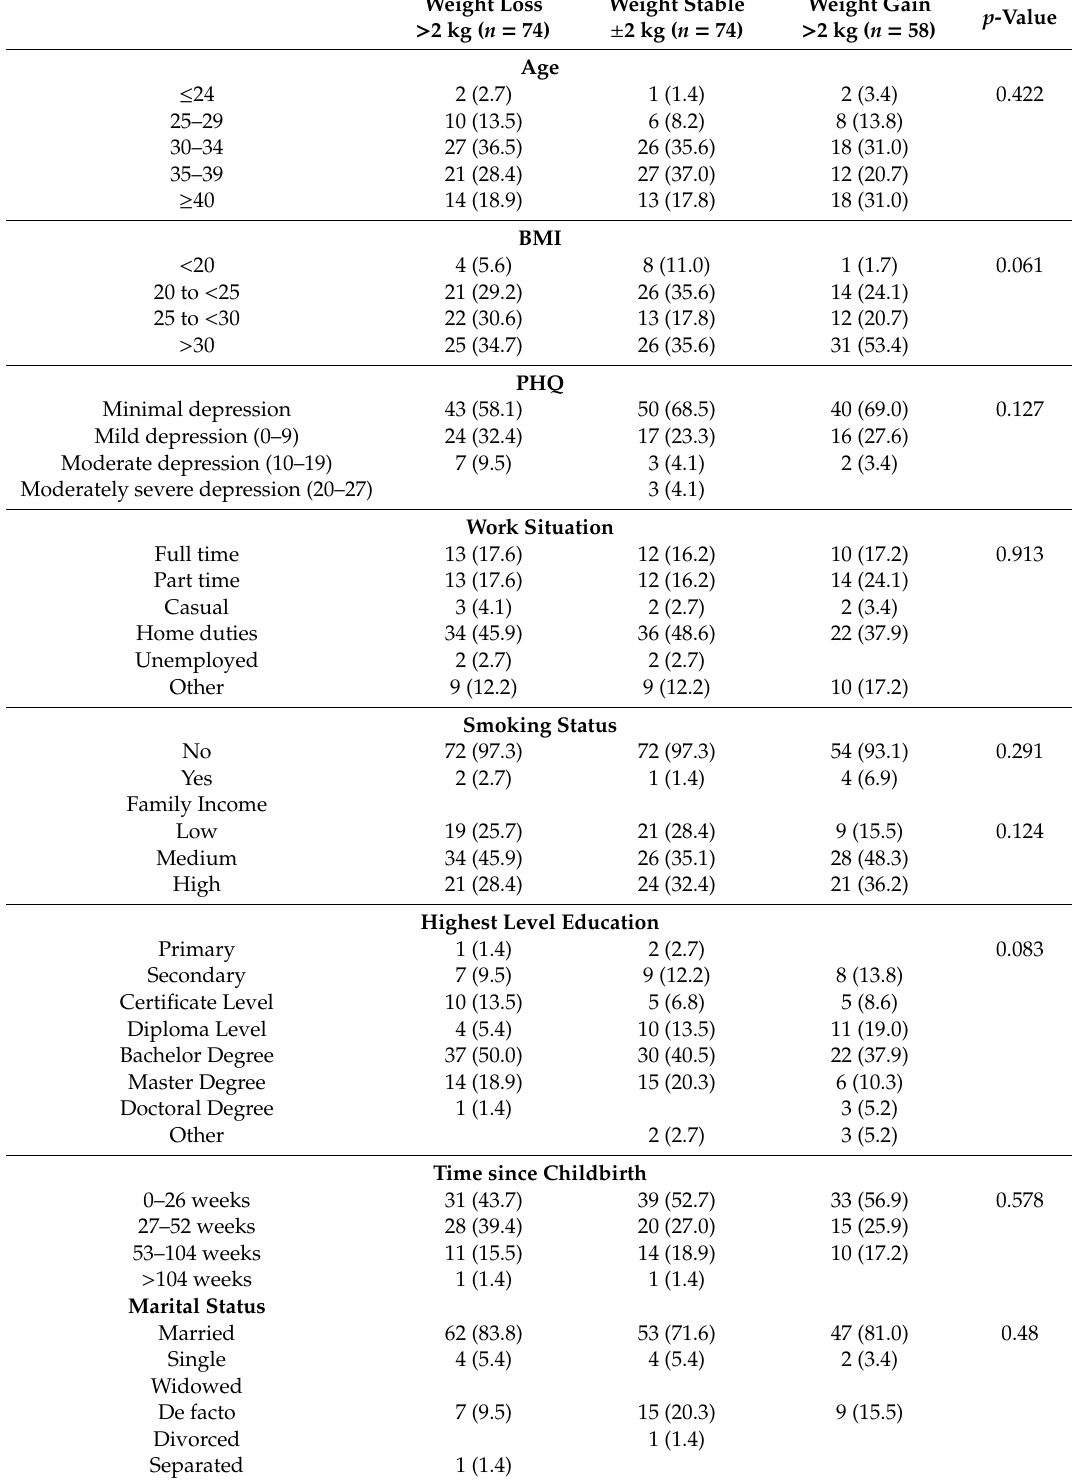
Table 1. Baseline characteristics of